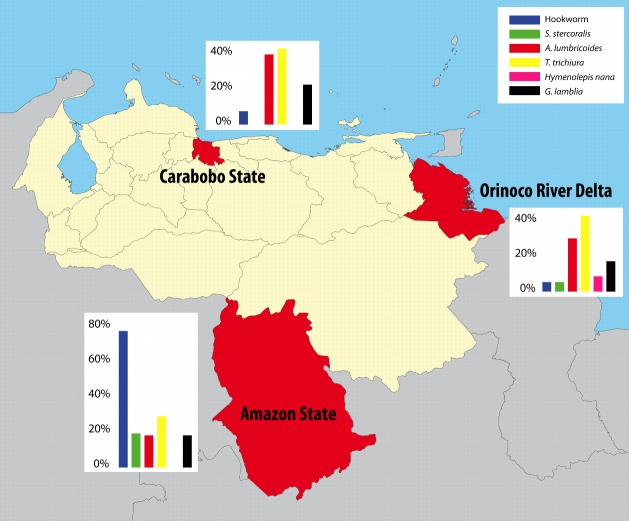
Location of study regions in Venezuela and prevalence of intestinal parasites per region.